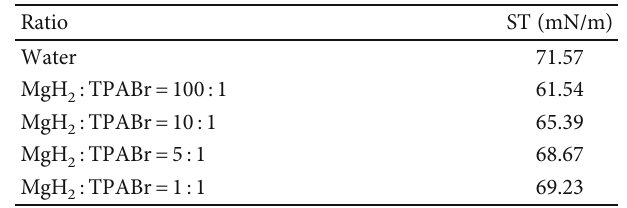
Figure 4: The e ff ect of di ff erent OTAC dosages on hydrogen Table 3: Surface tension values of aqueous solutions with di ff erent OTAC dosages.